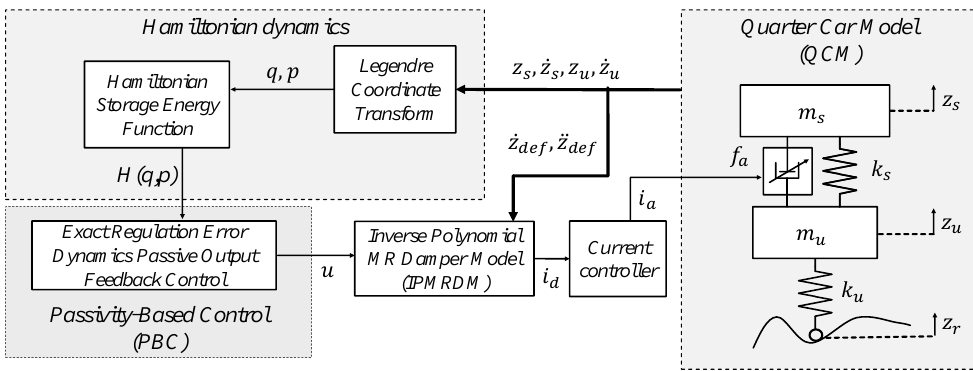
Figure 4. Proposed passivity-based control system for semi-active suspension with